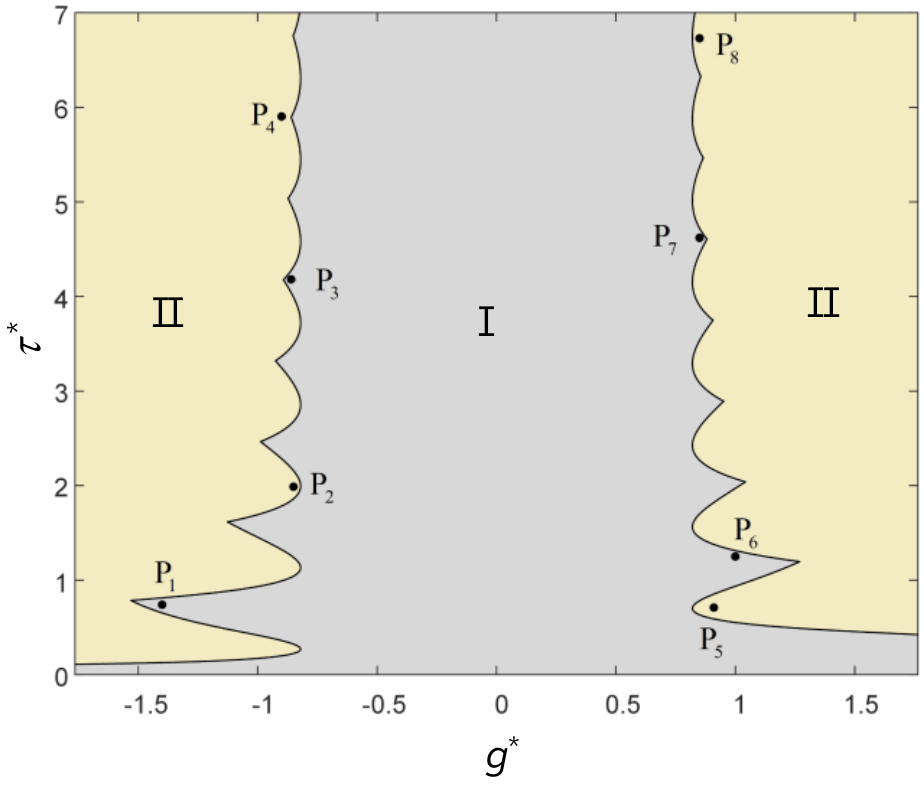
Figure 4. Time-delay dependent stability: Stable region; Unstable region.